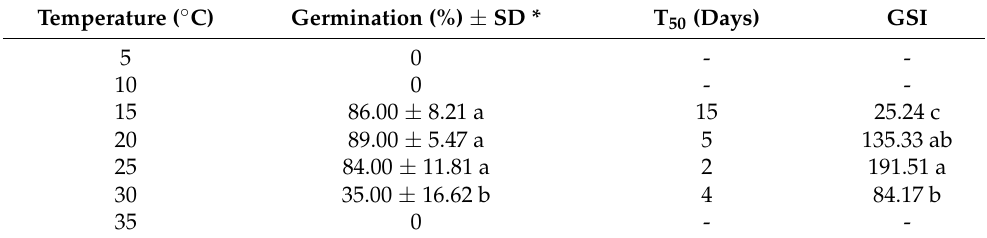
Table 1. In vitro germination of Dyckia brevifolia seeds, T 50 and germination speed index (GSI) at temperatures shown, after six months of storage at room temperature.